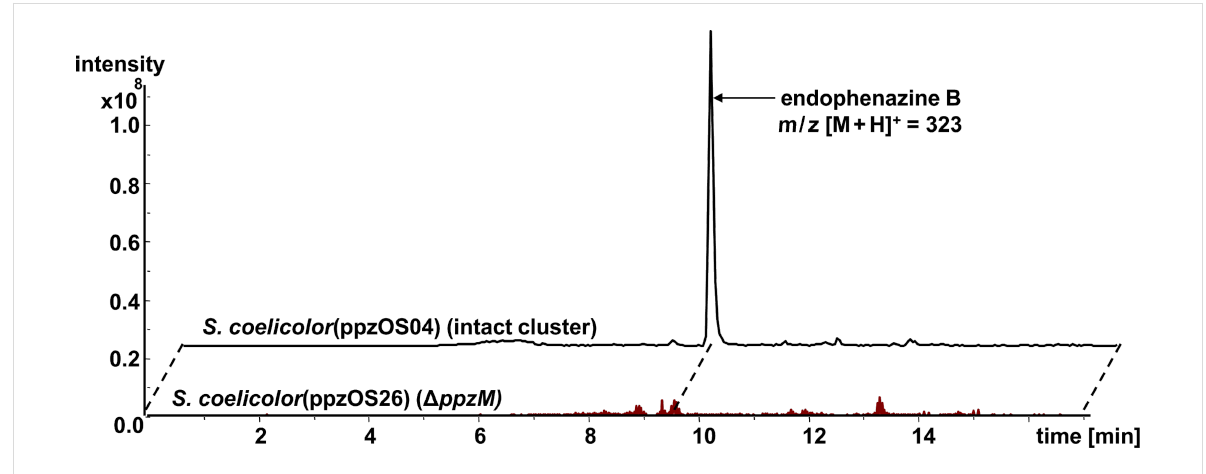
Figure 4: Extracted ion chromatograms for the mass of endophenazine B ( m / z [M + H] + = 323) in S. coelicolor M512(ppzOS04), and the mutant S. coelicolor M512(ppzOS26). The deletion of the gene ppzM reveals the abolishment of the production of endophenazine B.